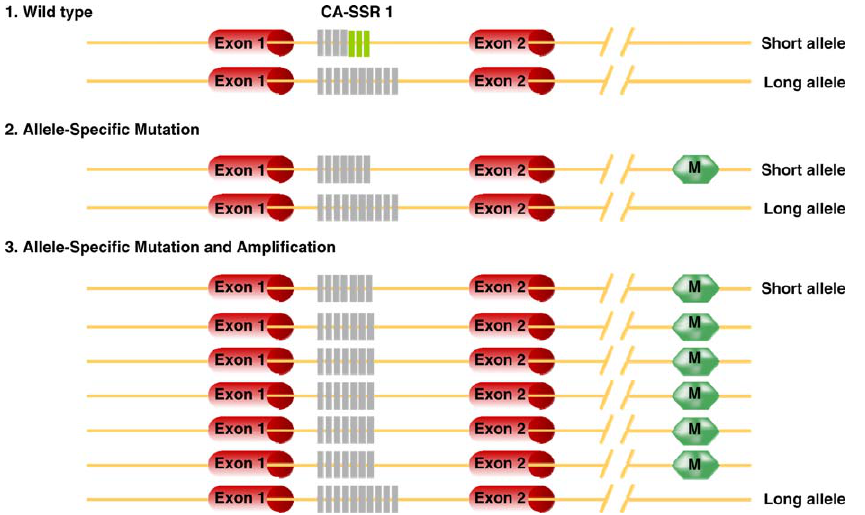
Figure 5. Hypothesized Allele-Specific Mutation and Amplification of EGFR in Lung Cancers We hypothesized that CA-SSR1 polymorphism occurs, mutations (M) target the EGFR allele with the shorter CA-SSR1 repeat number, and then there is allele-specific amplification. These three events, targeting the same allele, would be predicted to result in greater protein production than random allelic occurrence.